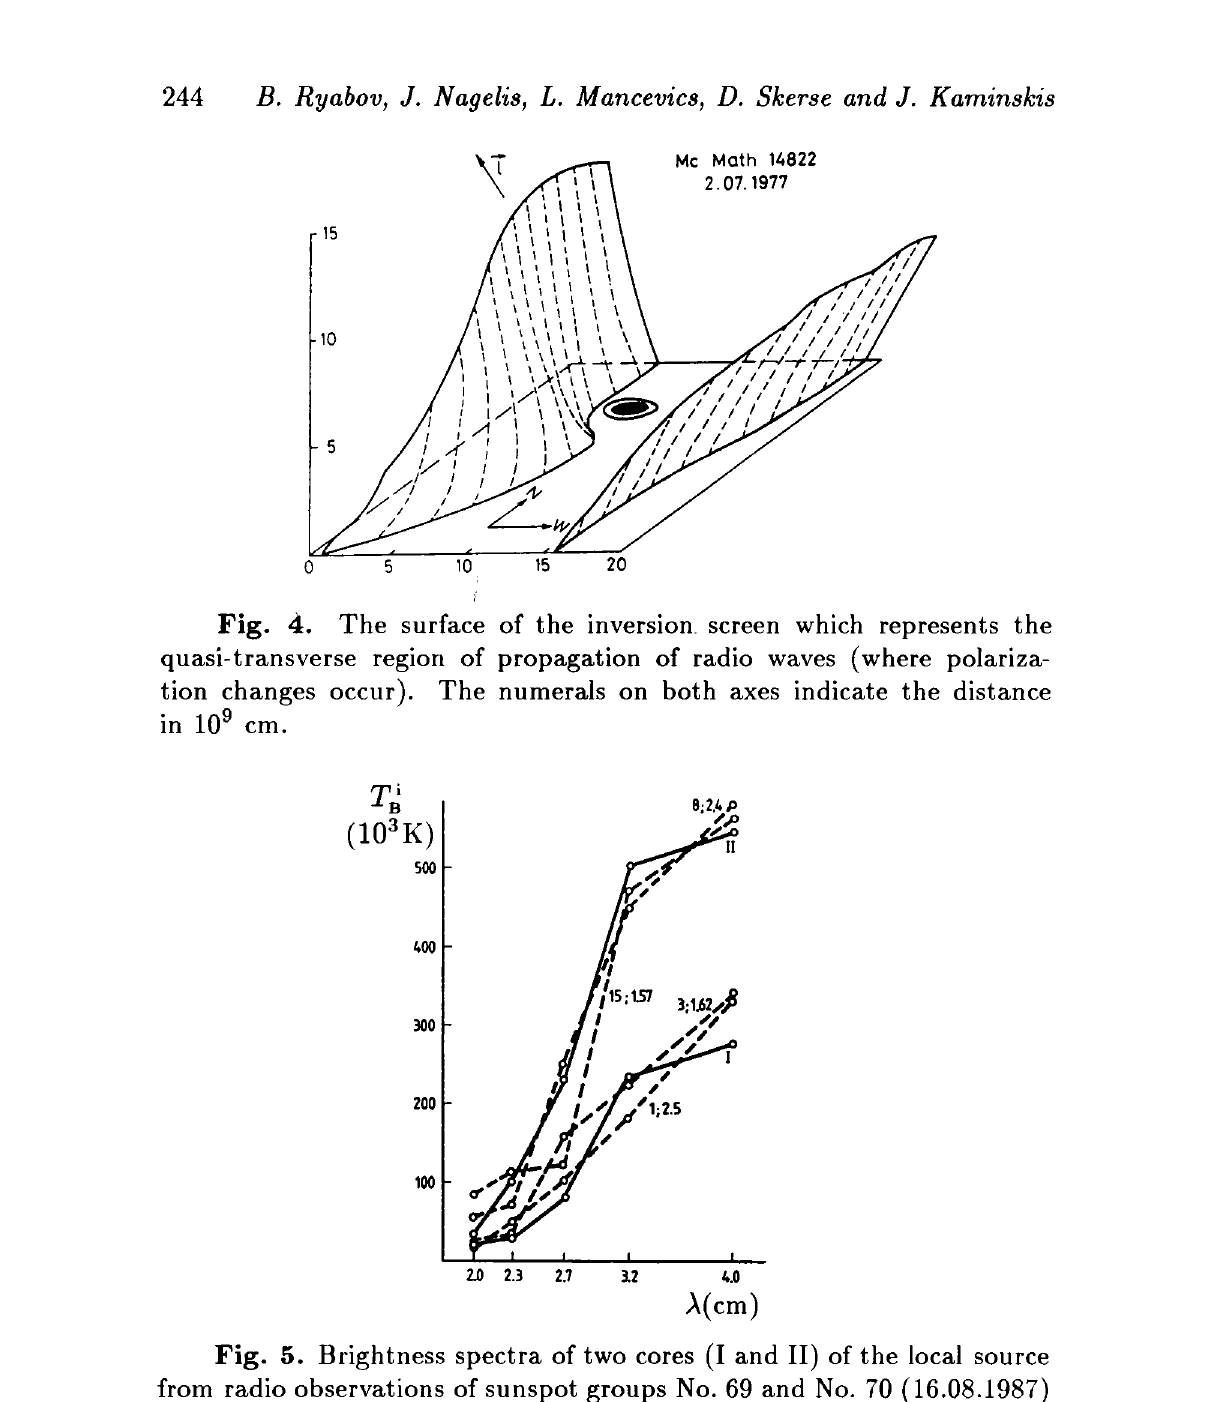
Fig. 5. Brightness spectra of two cores (I and II) of the local source from radio observations of sunspot groups No. 69 and No. 70 (16.08.1987) with the RATAN-600 (solid lines) compared with the model spectra (bro- ken lines). The conductive flux and the magnetic field variations are indi- cated by the pairs of